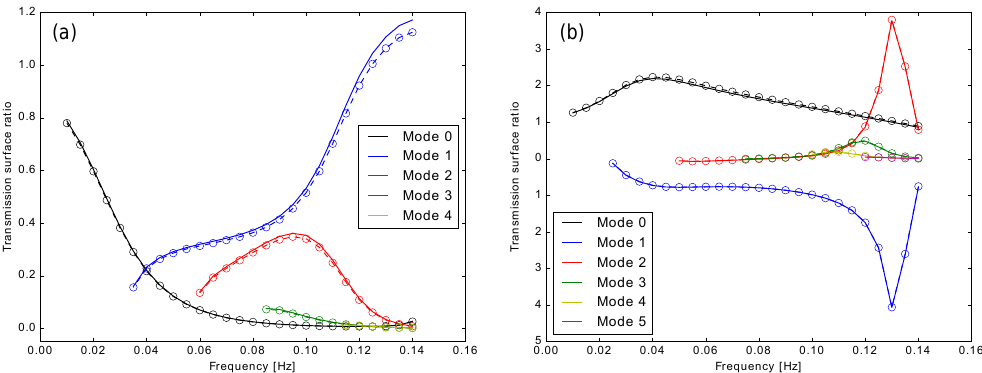
Figure 2. Transmission surface ratio obtained by the GAl method (solid lines) and GF method (dashed lines with circles), for an incident Love wave fundamental mode (mode 0) propagating through the original model L in the forward direction (a) and backward direction (b) . The SWRT package accounts for all the modes that exist in a given medium at a given frequency; note that in this figure the highest modes, where they exist, have negligible amplitudes. Here and in all following figures, the various surface wave modes are labelled according to their mode number, starting from 0 for the fundamental and increasing successively for each higher